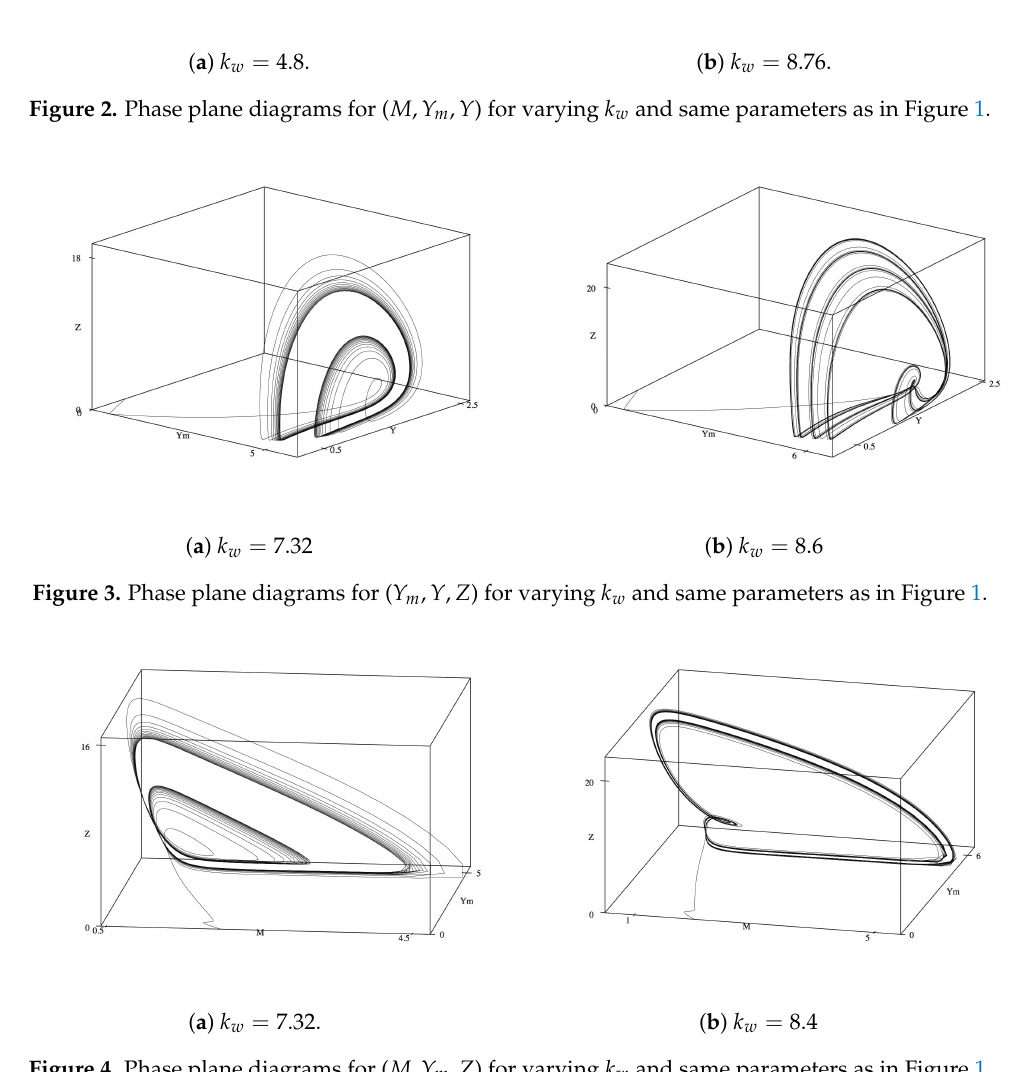
Figure 4. Phase plane diagrams for ( M , Y m , Z ) for varying k w and same parameters as in Figure